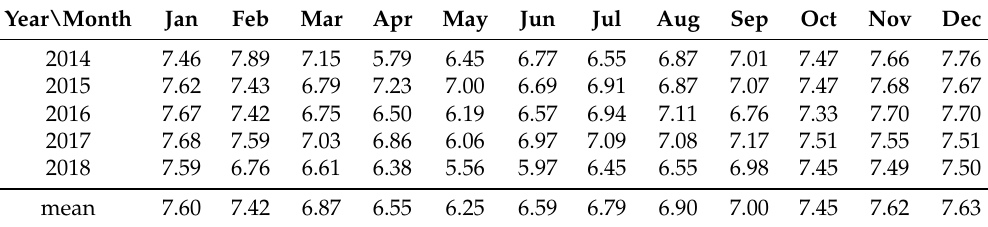
Figure A15. Time series of surface salinity on station ZG compared with VIEP observations and NEMO-Nordic model. Table A5. Monthly means for surface salinity for the years 2014–2018.